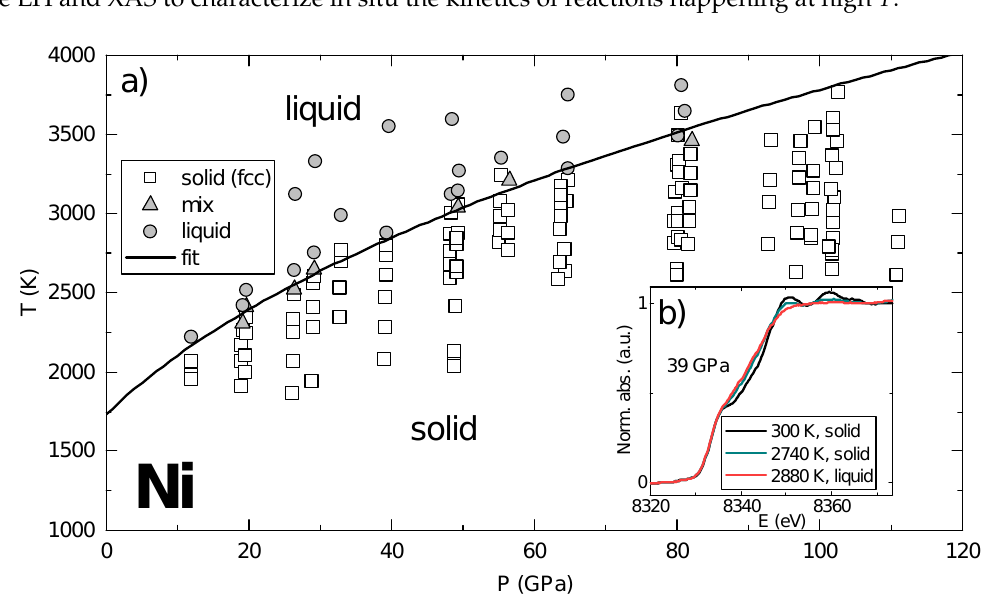
Figure 9. ( a ) Example results of a study on Ni performed using LH-DAC combined with XAS [28]. In the inset ( b ), the three XANES collected at 39 GPa show: solid nickel at ambient temperature, hot solid at 2740 K and a liquid at 2880